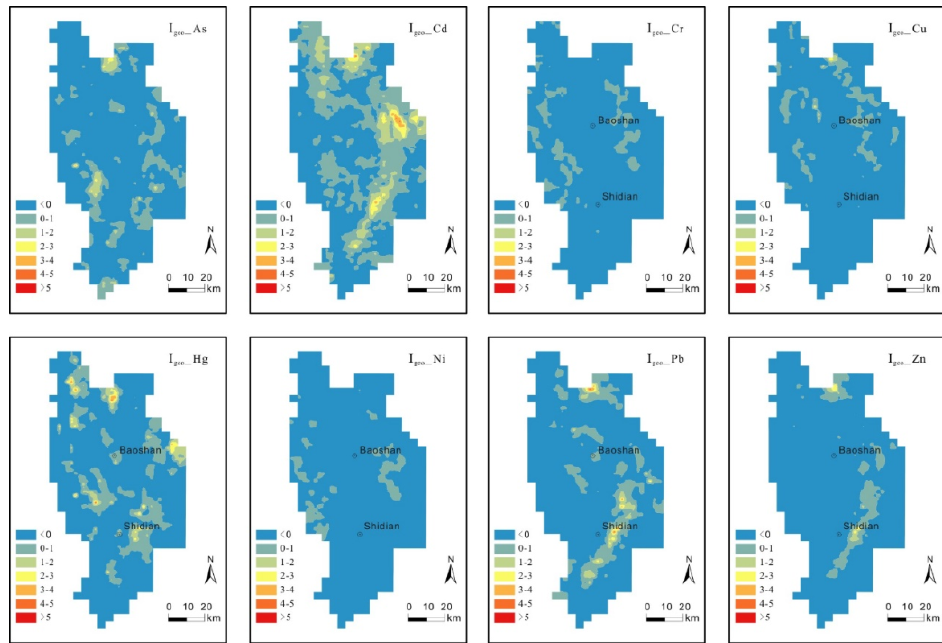
Figure 4. The distribution of counter maps of the geo-accumulation index (I geo ) determined by inverse distance-weighted (IDW) interpolation.